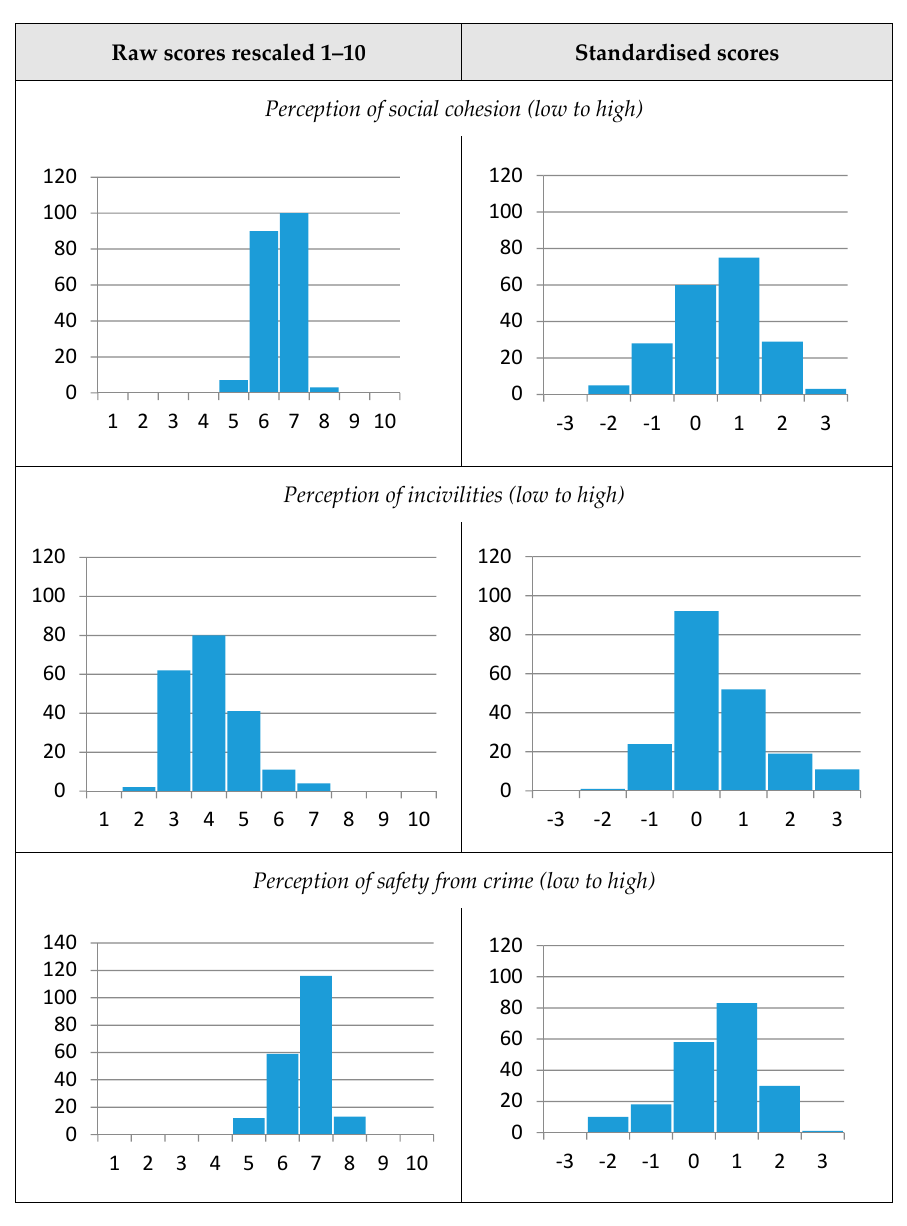
Figure 1. Distribution of social environment exposures (x axis) across the 200 HABITAT neighbourhoods (y axis).